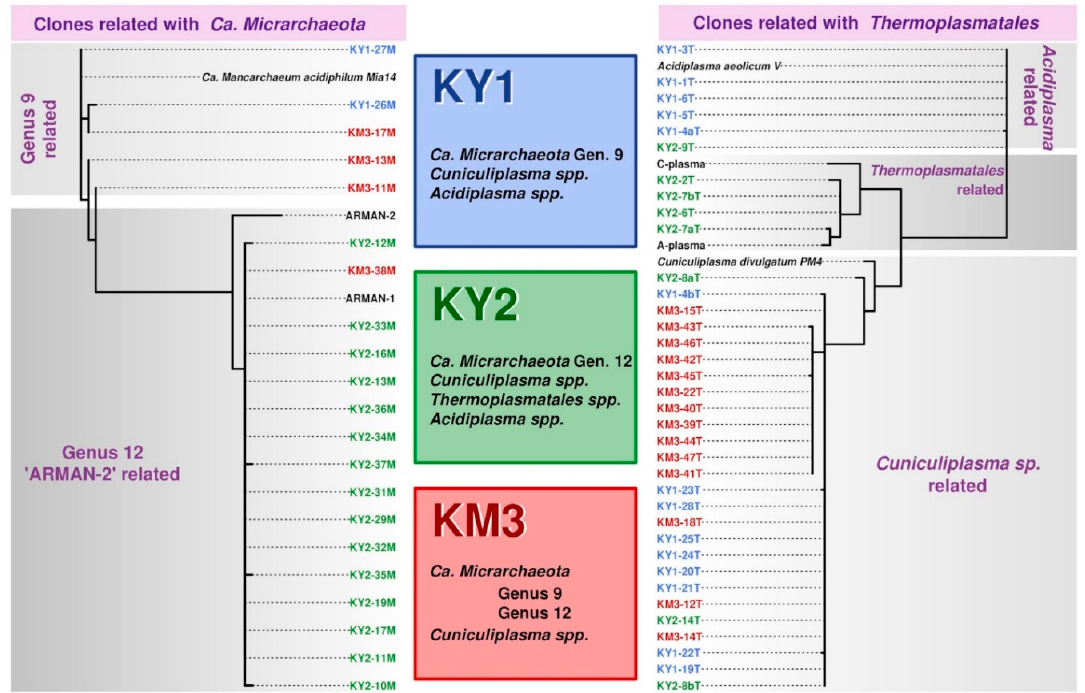
Figure 3. Representation of archaea (“ Ca . Micrarchaeota” and Thermoplasmatales ) in enrichment cultures established with Kunashir and Kamchatka